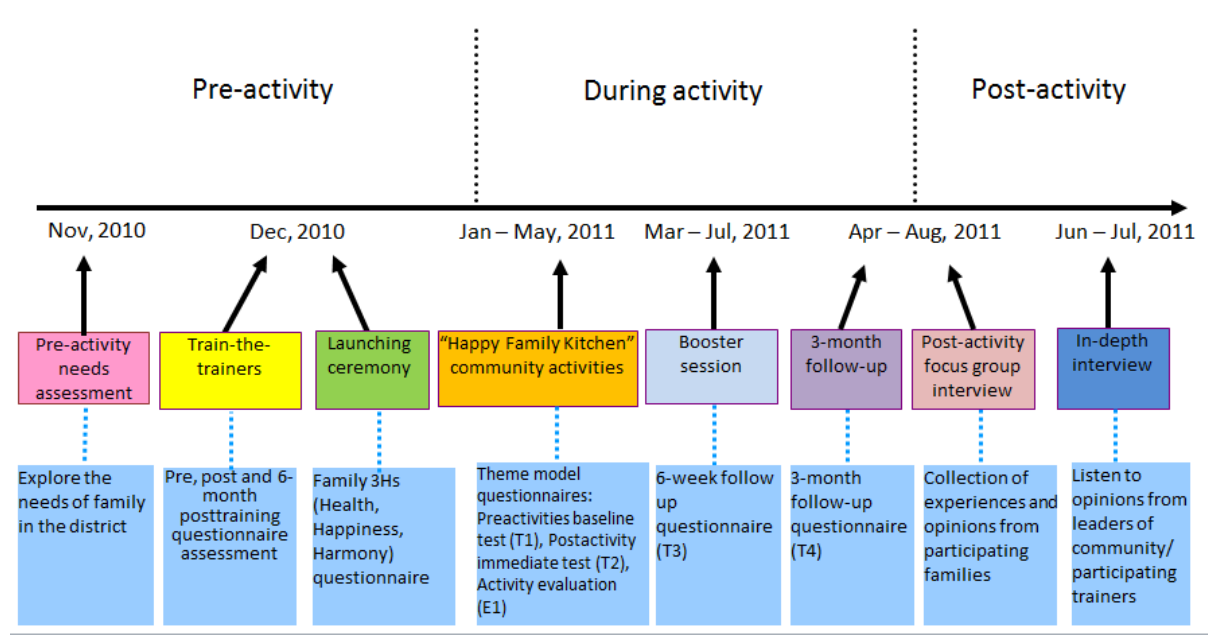
Figure 2. Evaluation of the Happy Family Kitchen